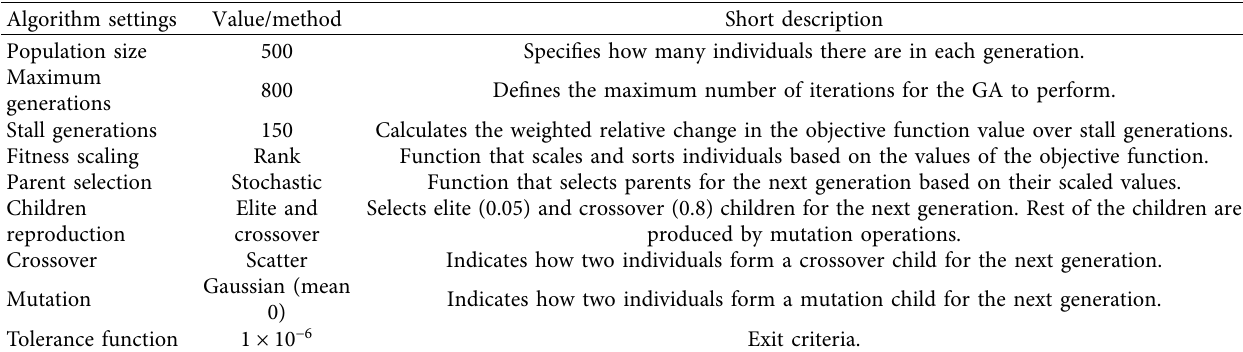
Table 8: Description of the genetic algorithm settings according to